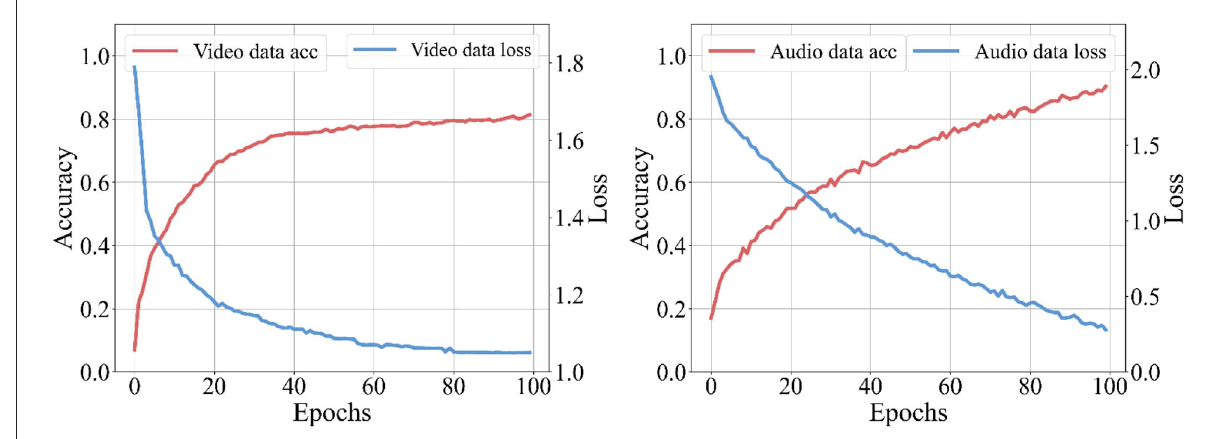
FIGURE2 Recognition accuracy and loss of the emotion recognition model.